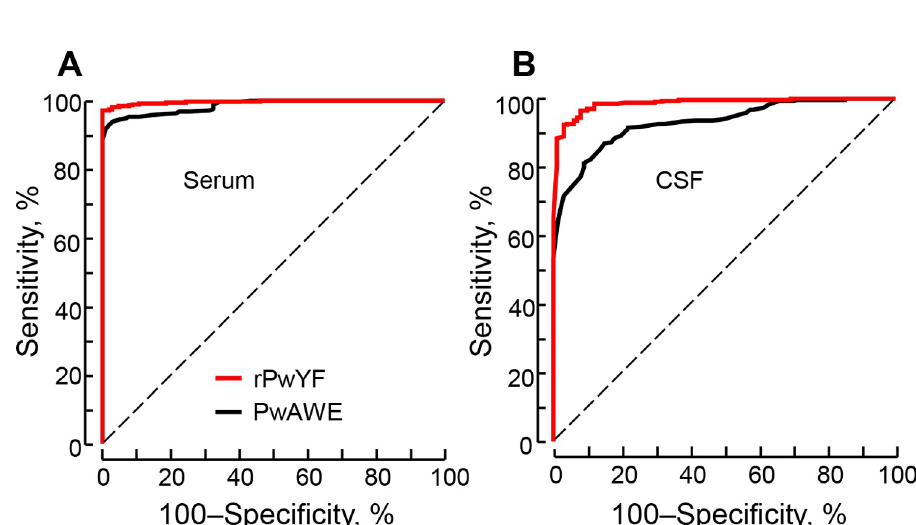
Fig 4. Analysis of receiver operating characteristic (ROC) curves. The ROC curves demonstrate the plots of sensitivity versus 1-specificity for serum (A) and CSF samples (B) against adult worm extract (PwAWE) (black line) and recombinant P . westermani yolk ferritin (rPwYF) (red line), respectively. The diagonal reference line is also shown. ROC curves were used to determine the cutoff values and area under the curve (AUC) each for PwAWE and rPwYF in serum ( n = 102) and CSF ( n = 101) samples by ELISA in cerebral paragonimiasis cases.